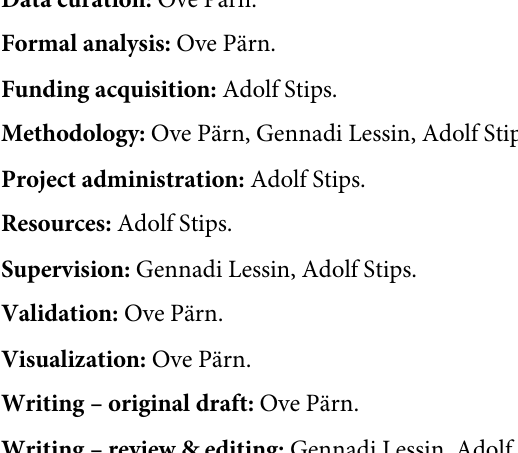
(TIFF) S8 Fig. Diatom and flagellate concentrations (Chl mg/m 3 ) at station OMBPK3 in spring 2011. (a) Diatoms (no ice run); (b) diatoms (ice run); (c) dinoflagellates (no ice run); (d) dino- flagellates (ice run); (e) and (f) are water densities with ice run and no ice run. The water den- sity is defined as the sigma density [(density(t,s,z)– 1000)] kg/m 3 . S1 Table. Peak of chlorophyll-a in April 2013. Data from Baltic Nest, ICES and satellite data from Copernicus database. S2 Table. The table shows dia/dino index and records stating the existence of ice. Phyto- plankton events based on observations. Cases, which developed under ice cover, as illustrated in figures, have been marked with an asterisk. Stations location A (58.35˚N;18.14˚E) and B (57.3˚N;20.1˚E). Ice concentration for up to 10 days before